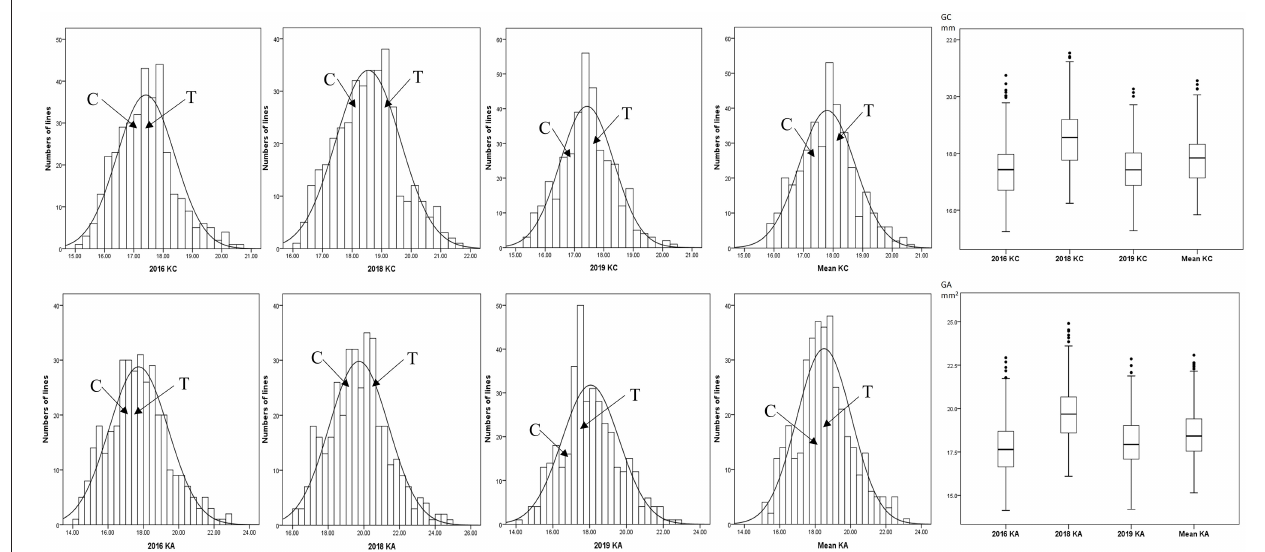
FIGURE 1 | Phenotypic frequency distribution and box plot of kernel size in RIL Population. C, CN18; T,